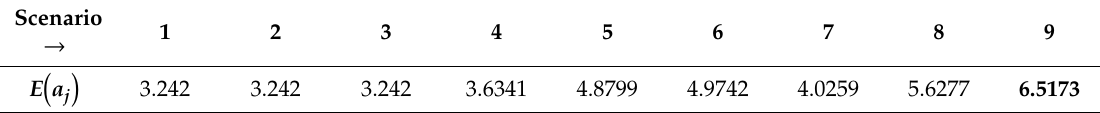
Table 9. Utility values matrix for irrigation scenarios.